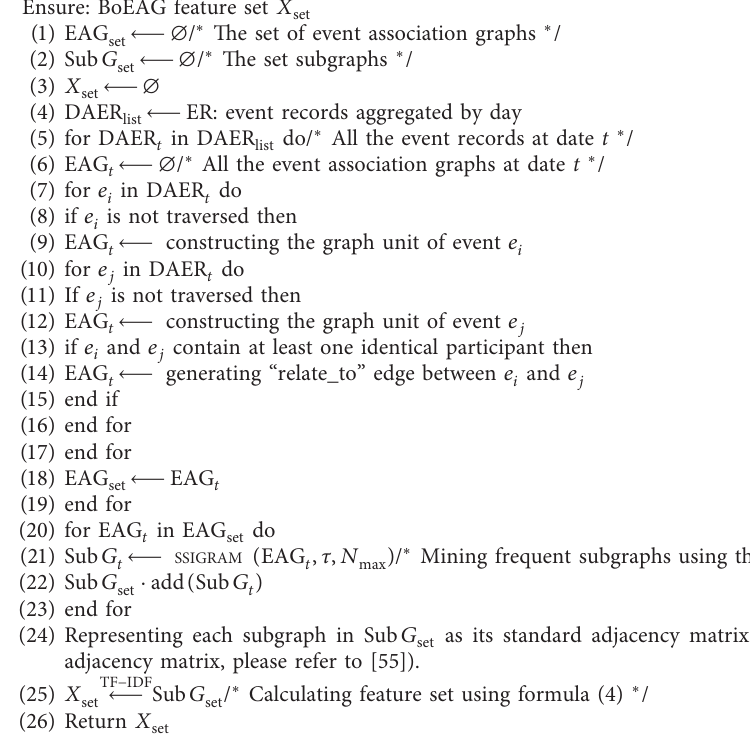
A LGORITHM 1:The algorithm of BoEAG feature construction.